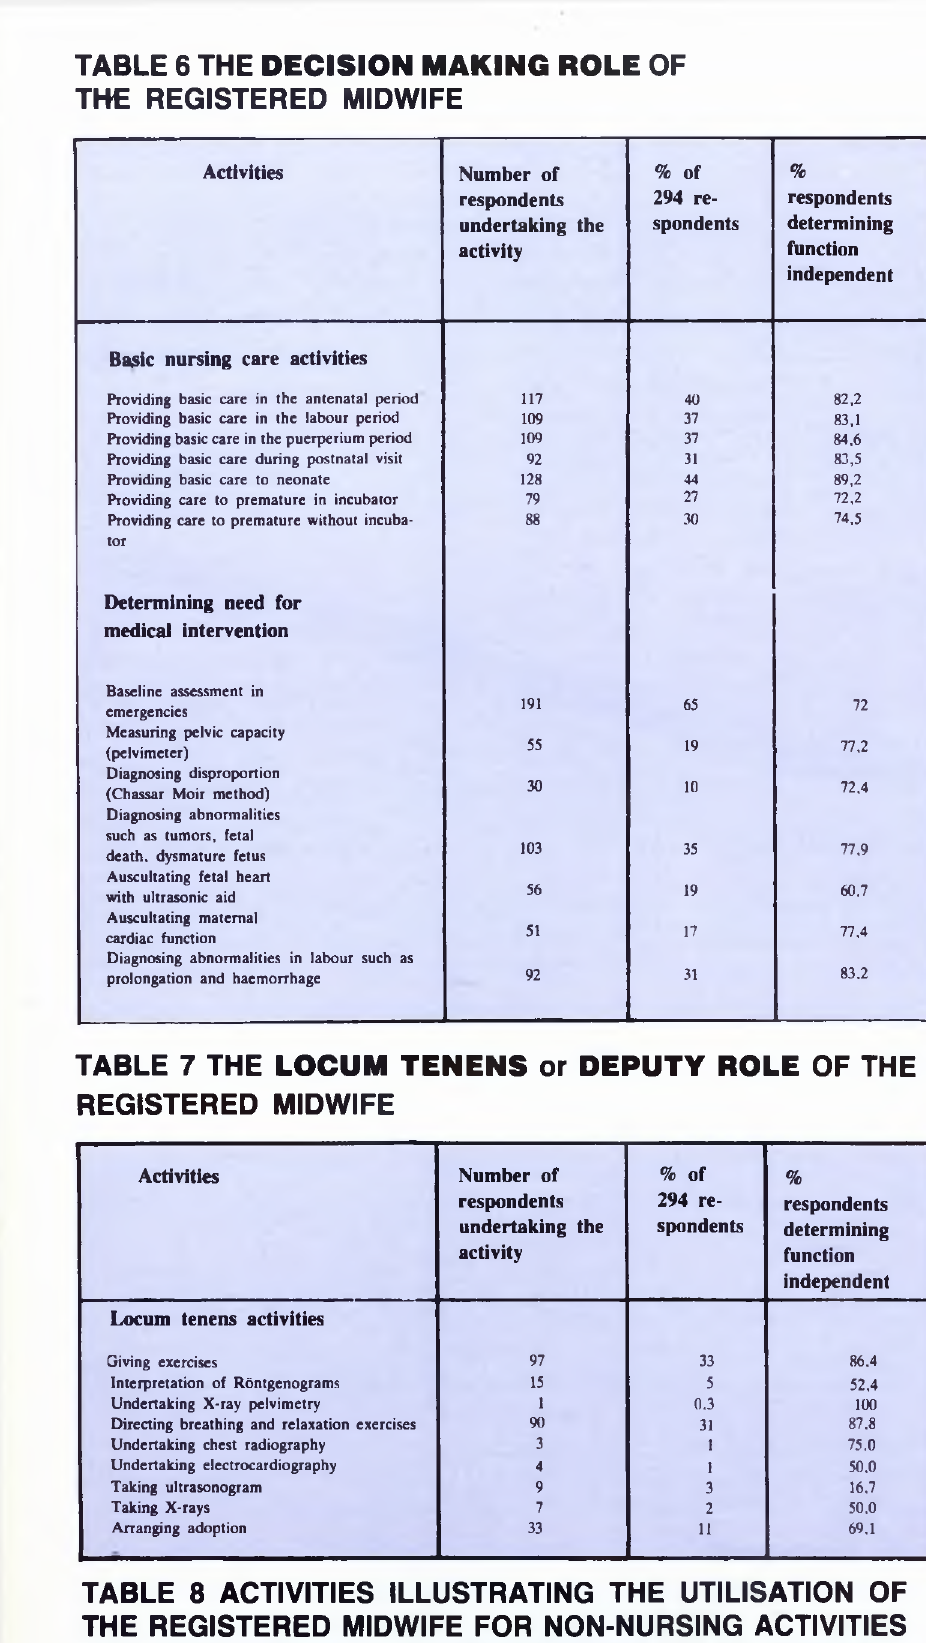
TABLE 8 ACTIVITIES ILLUSTRATING THE UTILISATION OF THE REGISTERED MIDWIFE FOR NON-NURSING ACTIVITIES AND THE NUMBER AND PERCENTAGE OF 294 RESPON­ DENTS UNDERTAKING THE